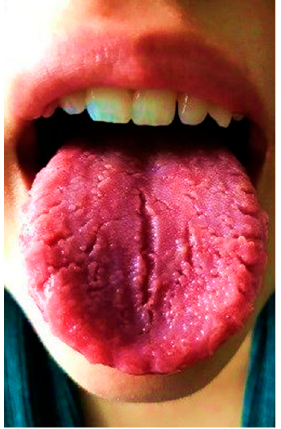
Figure 2 . Fissured tongue (Patient 1).